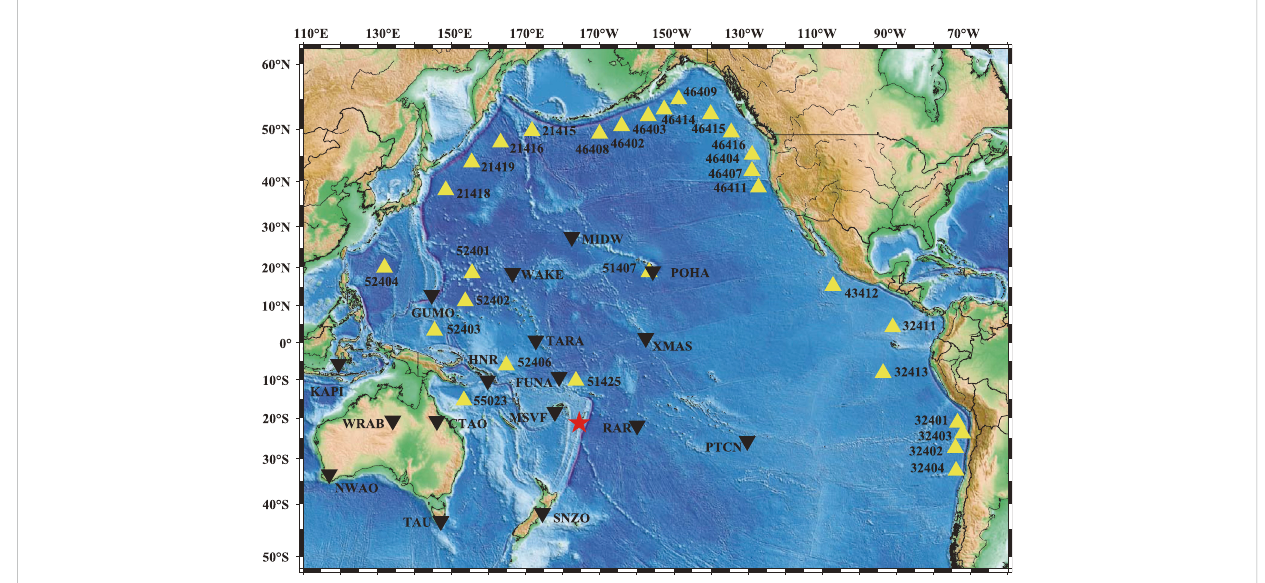
FIGURE 3 Seismic stations (black triangles) and ocean bottom pressure gauges (yellow triangles) used in this